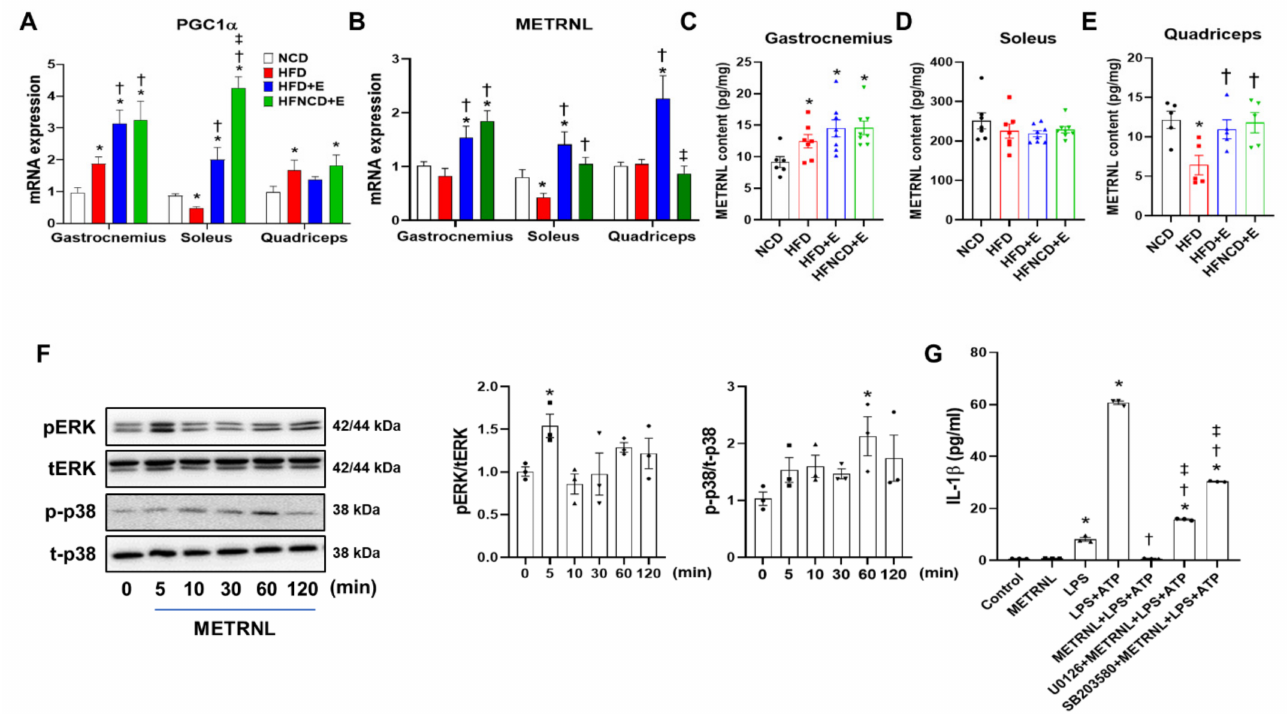
Figure 6. METRNL is induced by exercise in muscle and inhibits NLRP3 inflammasome activation in BMDMs. Gene expression levels of PGC1 α ( A ) and METRNL ( B ) in the gastrocnemius, soleus, and quadriceps muscles were measured in mice using real-time PCR and normalized to 18S rRNA levels. ( C – E ) METRNL protein content in soleus, gastrocnemius, and quadriceps was measured using ELISA. ( F ) Representative Western blots and quantification showing time-dependent activation of ERK and p38 MAPK signaling in METRNL-treated (100 ng/mL) BMDMs. BMDMs were isolated from 5-week- old male C57BL/6 mice. The phosphorylated protein levels were normalized to total protein levels (p = phosphorylated, t = total) ( G ) BMDMs were treated with U0126 (30 µ M) and SB203580 (30 µ M) for 1 h, followed by METRNL (100 ng/mL) for 1 h and LPS+ATP treatment for 6 h. The supernatant was collected, and IL-1 β was measured using ELISA. Values are presented as mean ± SEM. * p < 0.05 compared with NCD, † p < 0.05 compared with HFD, ‡ p < 0.05 compared with HFD+E ( A – E ). Values are presented as mean ± SEM of triplicate. * p < 0.05 compared with control, † p < 0.05 compared with LPS+ATP, ‡ p < 0.05 compared with METRNL+LPS+ATP ( F – G